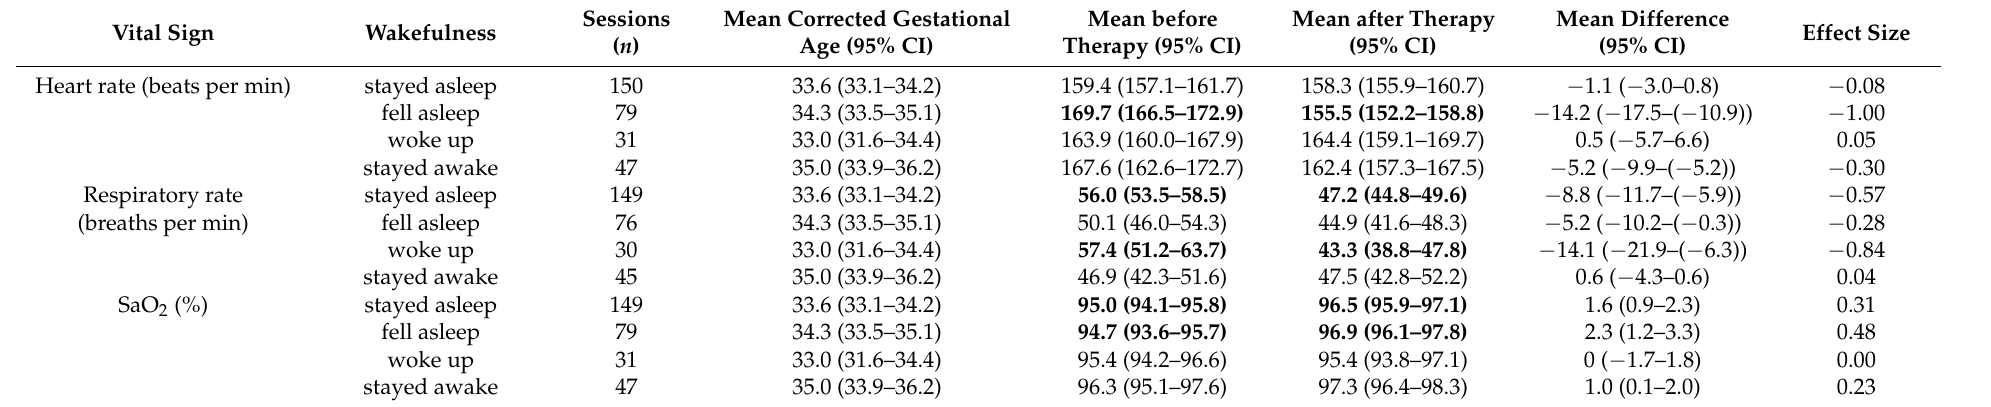
Table 3. Response to music therapy by evolution of wakefulness during music therapy